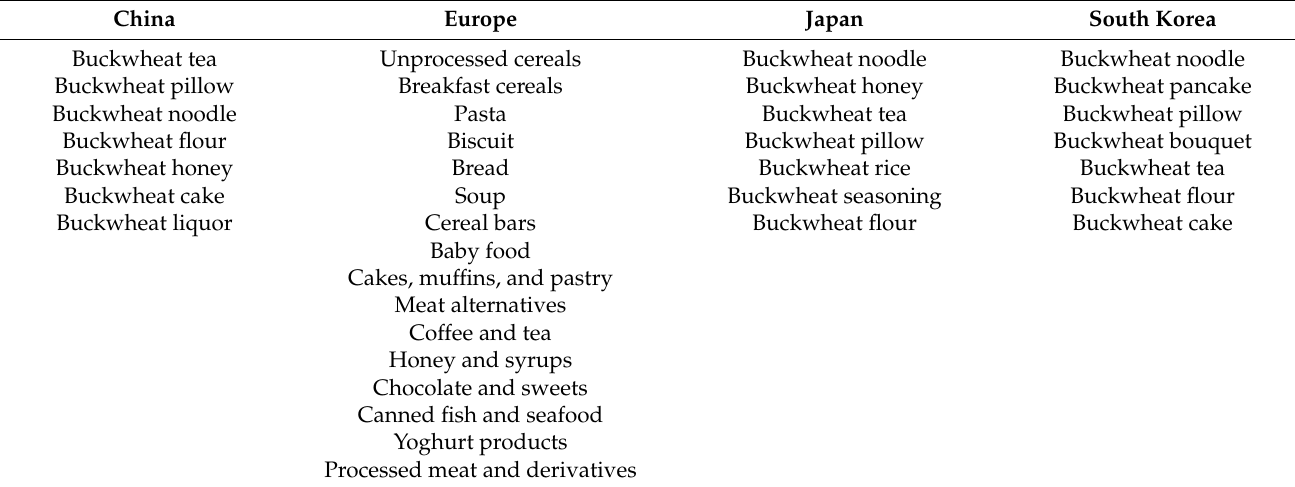
Table 5. International buckwheat products.